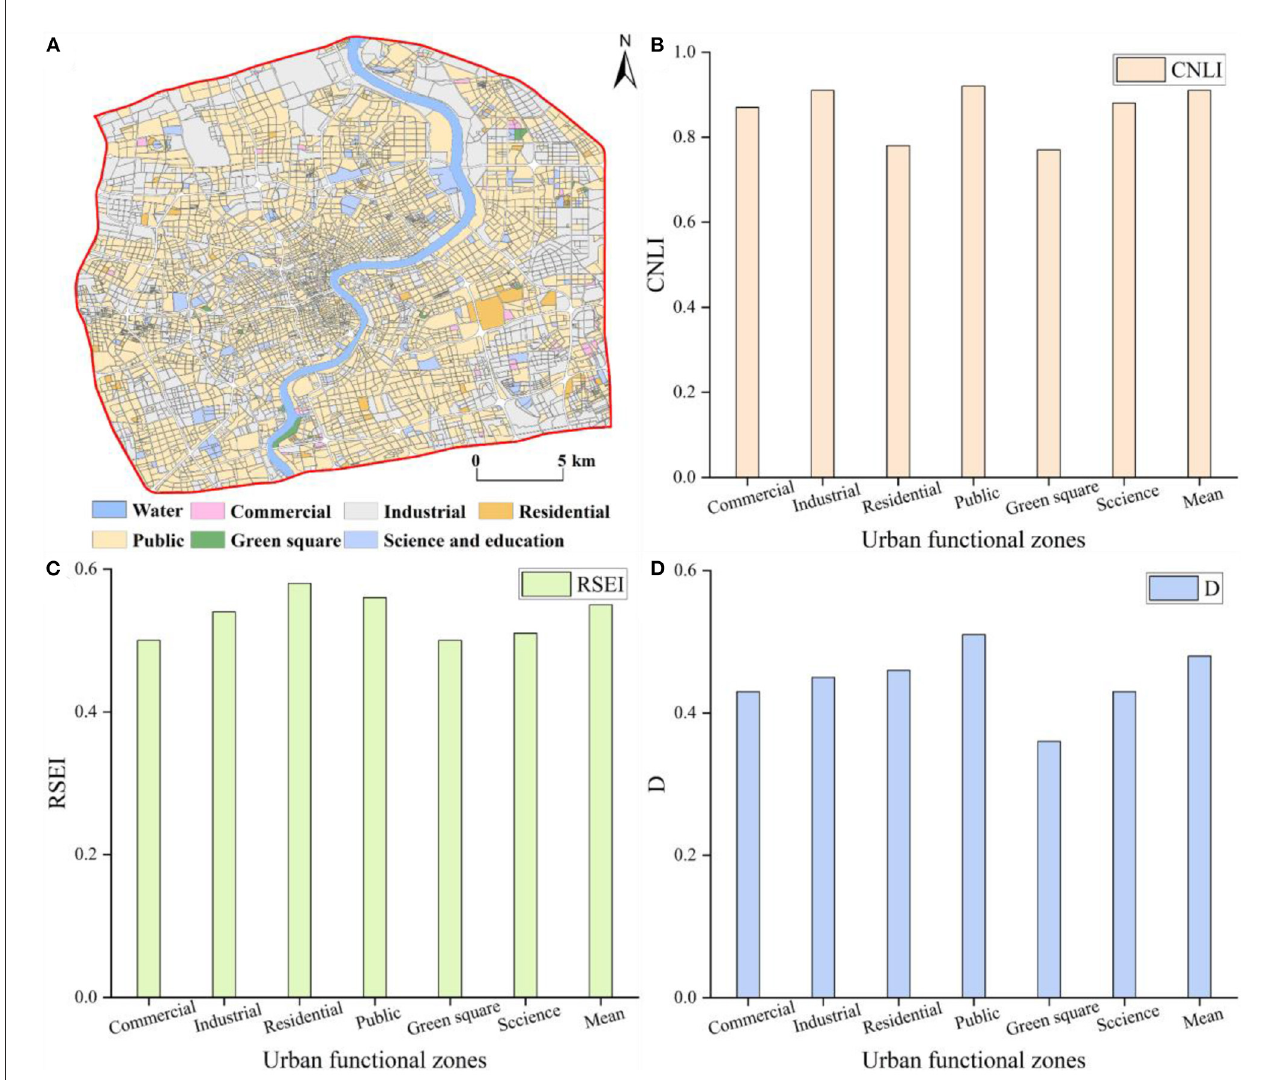
FIGURE5 Differences in indices in various urban functional zones (A) functional zones by dominant type, (B) CNLI, (C) RSEI, and (D) D.